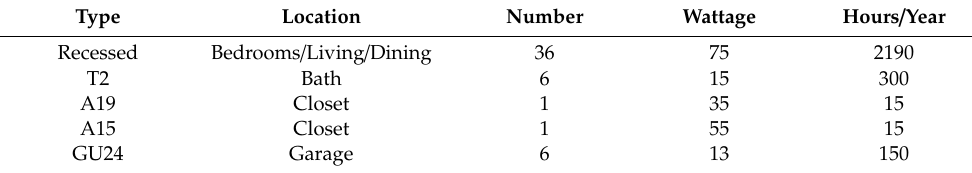
Table 7. Lighting systems.